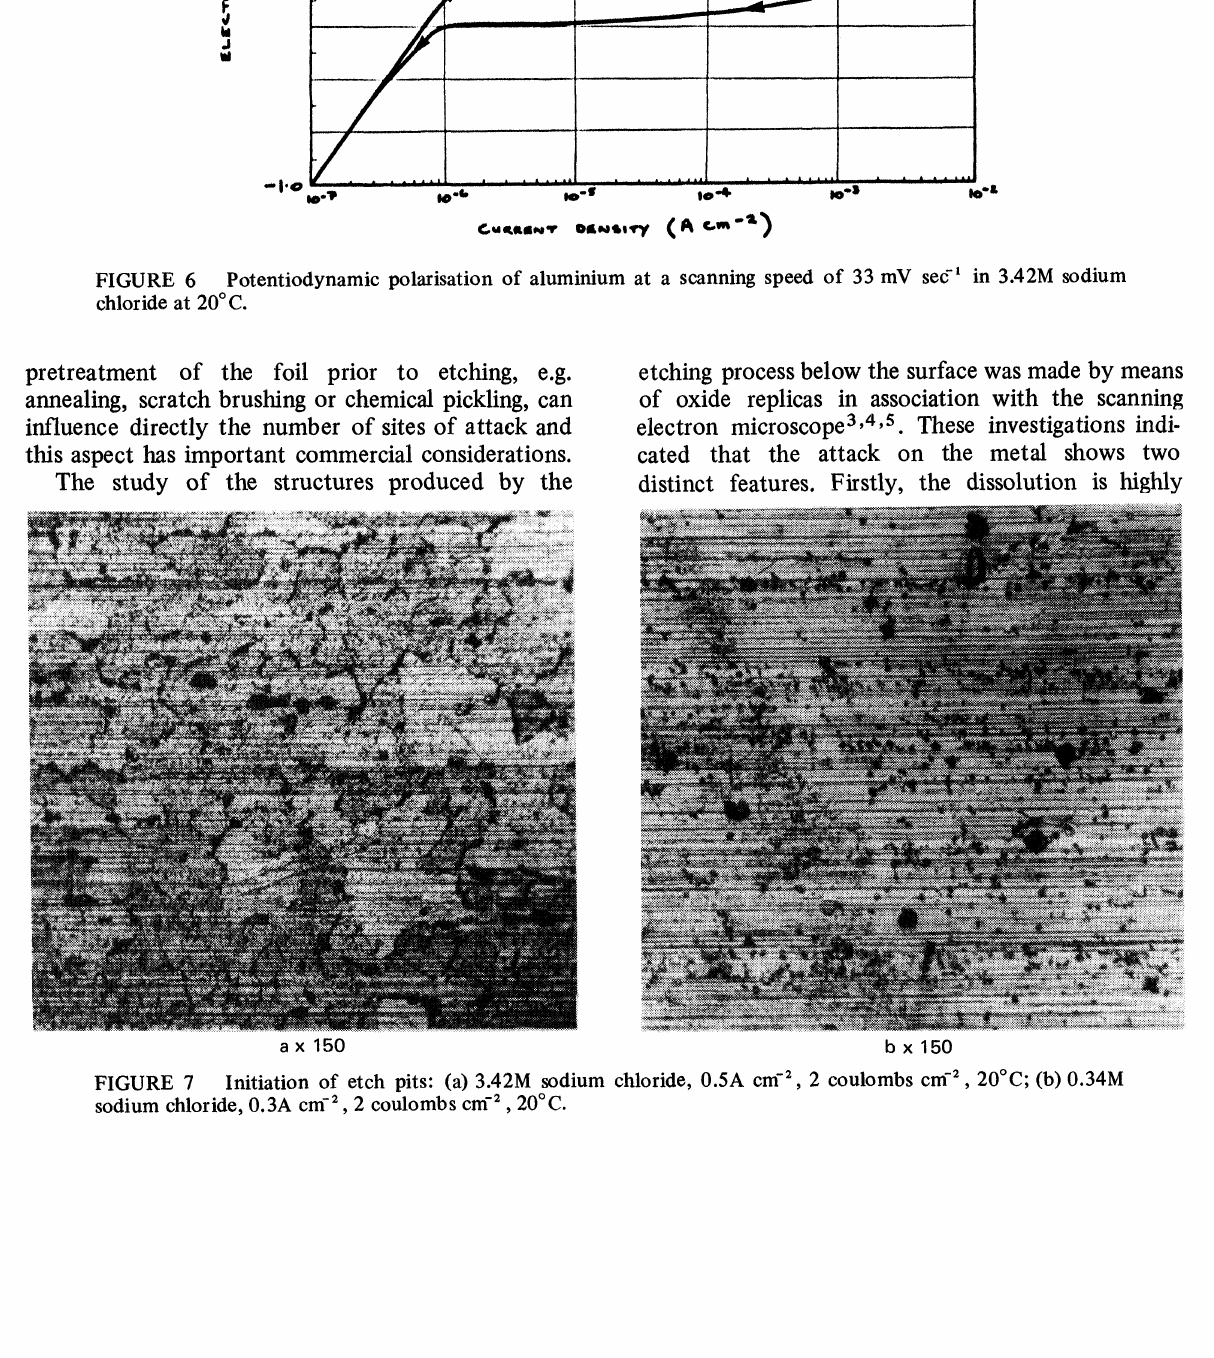
- FIGURE 7 Initiation of etch pits: (a)3.42M sodium chloride, 0.5A crn -2 2 coulombs cm 20C; (b)0.34M 2 coulombs crn -2 sodium chloride, 0.3A cm